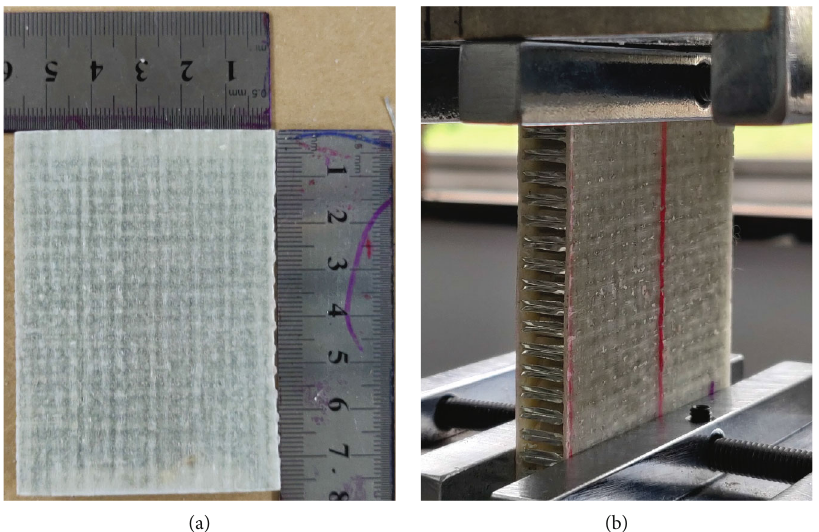
Figure 5: Edgewise compression test: (a) actual specimen size and (b) experimental setup.